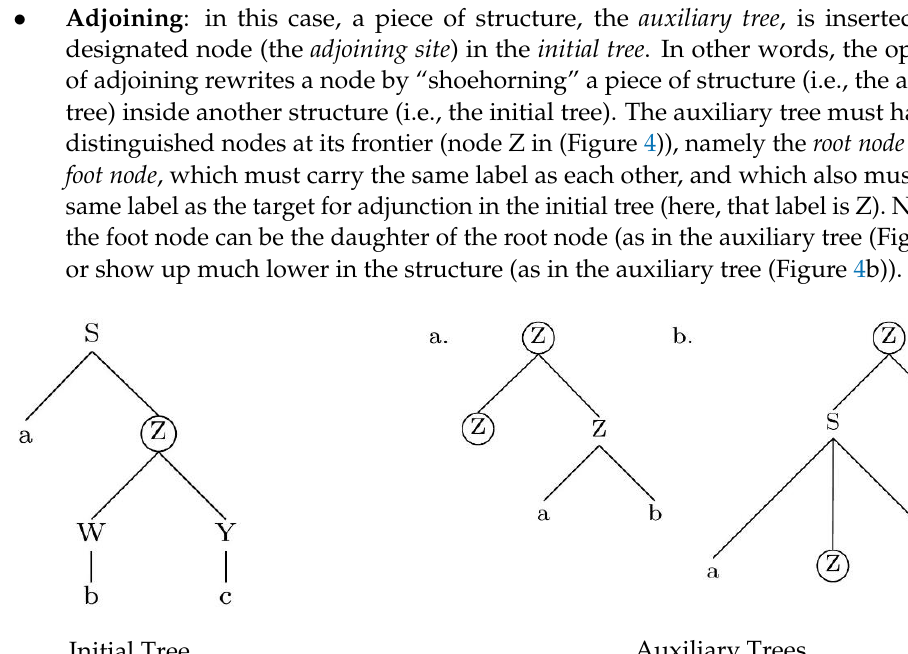
Figure 3. Substitution .